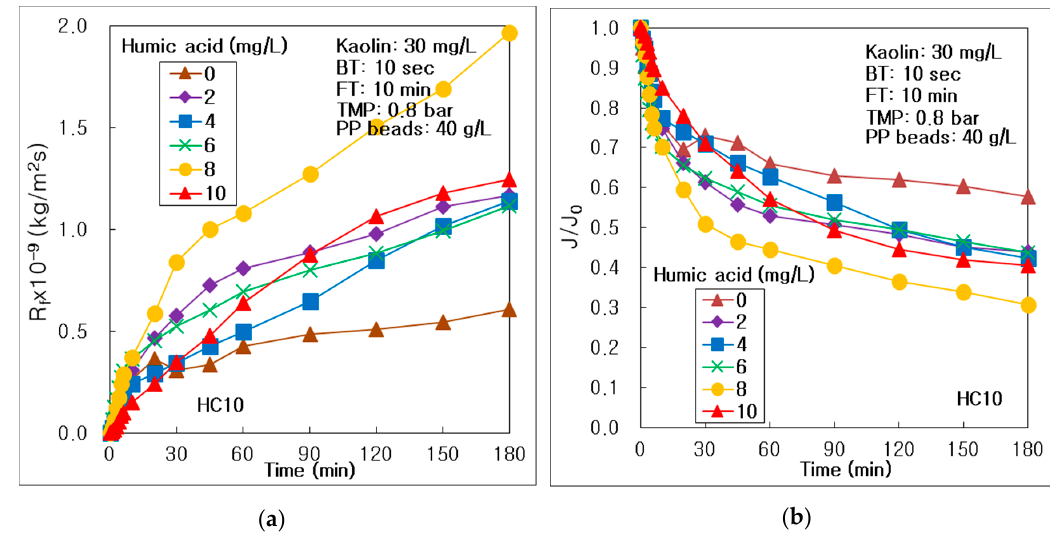
Figure 2. Effect of humic acid concentration in the hybrid process of multichannel alumina MF and PP beads with UV irradiation and periodic water backwashing: ( a ) Resistance of membrane fouling and ( b ) dimensionless permeate flux.